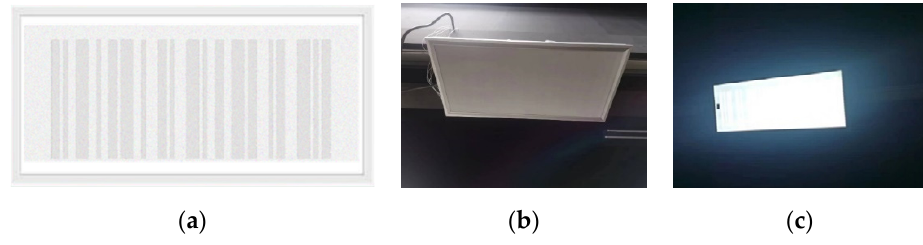
Figure 2. Retrofitted flat panel light: ( a ) ideal model; ( b ) lights off; ( c ) lights on. LED flat panel light is a flat surface light source, and compared with traditional lamps and lanterns, the light source wattage is the same. LED flat panel light has the advantages of a soft light, a uniform, large luminous area, a high color rendering index, green energy saving, etc., which are becoming characteristics of choice for indoor lighting.